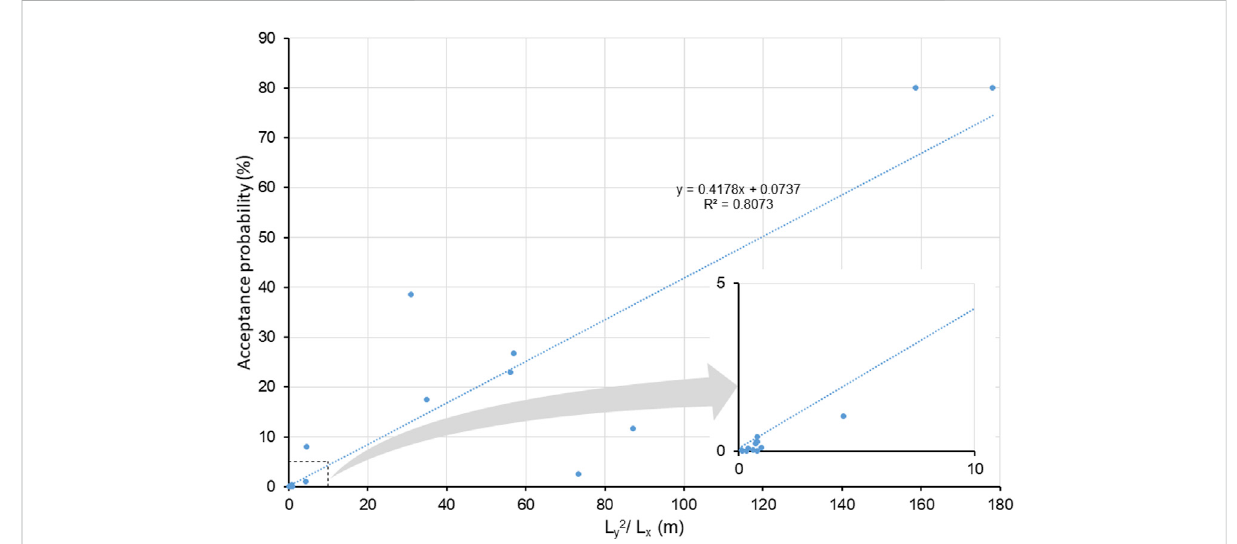
FIGURE 5 Relationship between theproportion of realizationsmeeting the smoke tracer plausibilitytest (Acceptance probability) and aratio L y 2 /L x , which is the squared OFG category mean length in the paleo fl ow direction (L y ) and perpendicular to the paleo fl ow direction (L x ). This relationship is shown for 21 TP models examined for the Kyle case study as summarized in Table